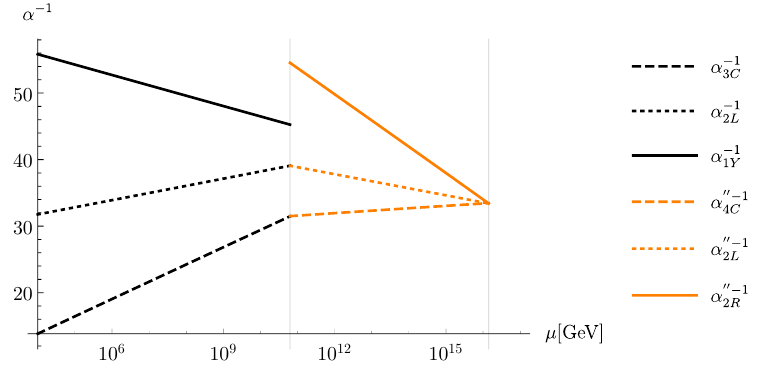
Figure 1 . Running and gauge coupling uni(cid:12)cation in Model 1 in the case of minimal threshold corrections.